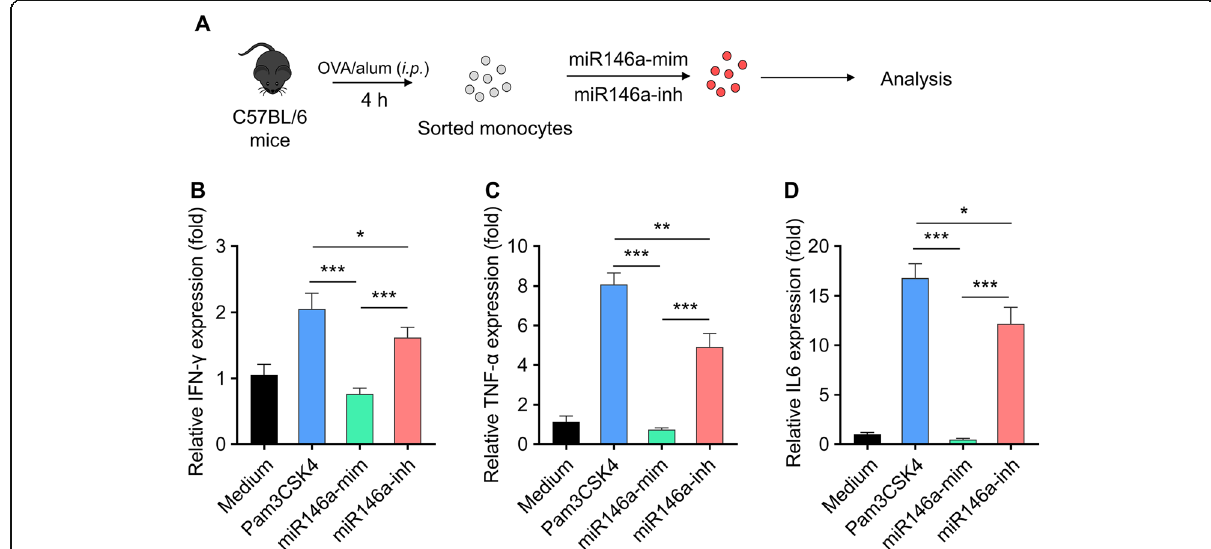
Fig. 2 Effect of miR-146a mimics and miR146a inhibitor on activation of TLR2 signaling in monocyte. a C57BL/6 mice were treated with OVA/ alum (i.p.), and PLF (peritoneal lavage fluids) were harvested 4 h after treatment to purify inflammatory monocytes by sorting. Sorted monocytes were transfected with miR-146a mimics or miR146a inhibitor (500 nM) for 3 days, the TLR2 agonist was set as positive control. Expressions of Th1- type cytokines, including IFN- γ b TNF- α c and IL-6 d were analyzed by real-time PCR. Data represent means ± SD, n = 3, *** p < 0.001. The in vitro experiments were repeated three